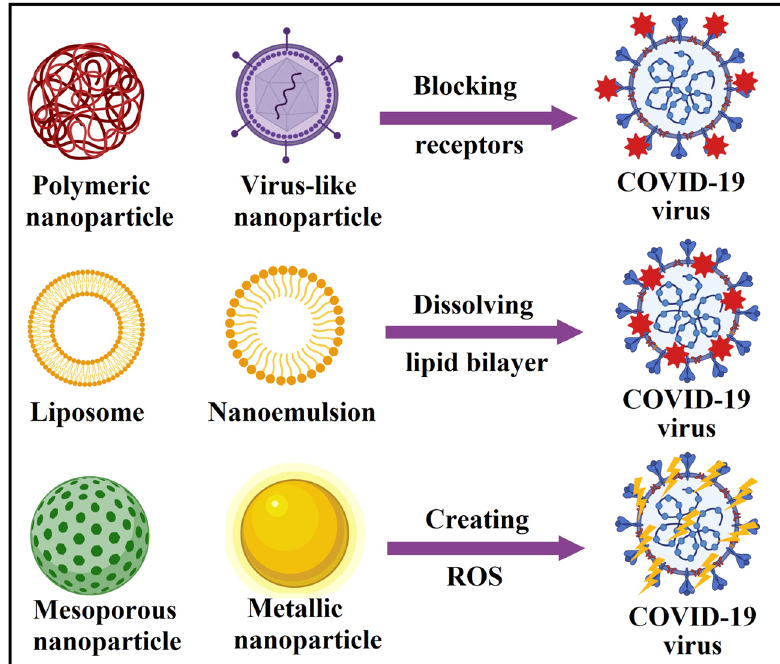
Figure 14: Nanomaterials as powerful disinfectants for CoV removal ( di ff erent reaction mechanisms )